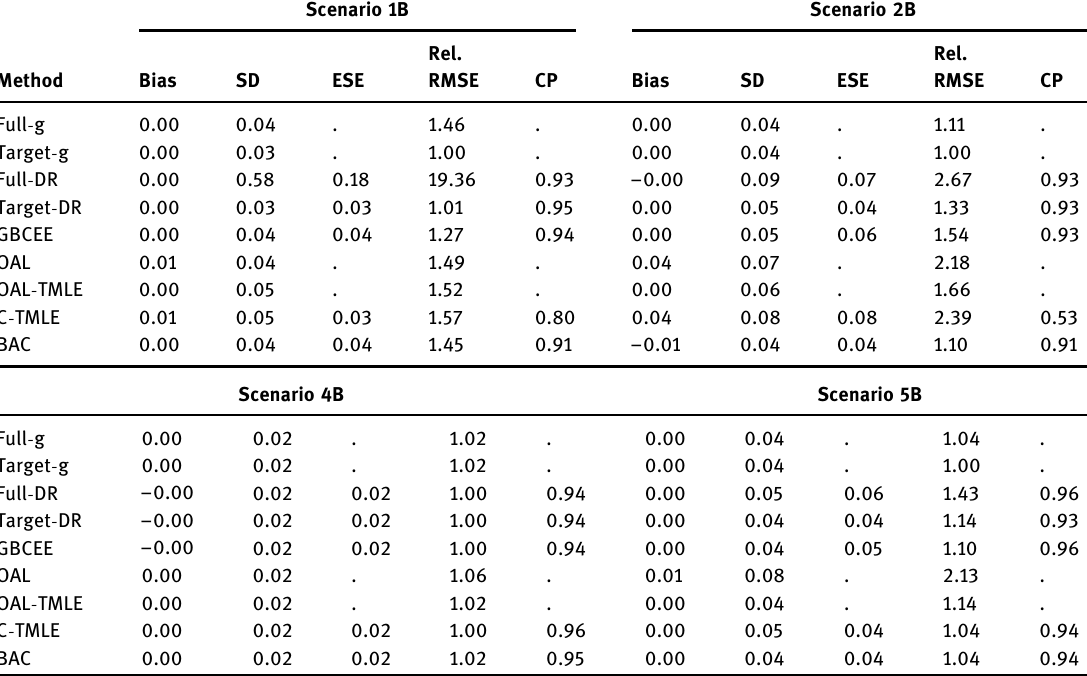
Table A5: Results of simulation Scenarios 1B, 2B, 4B, and 5B, with n